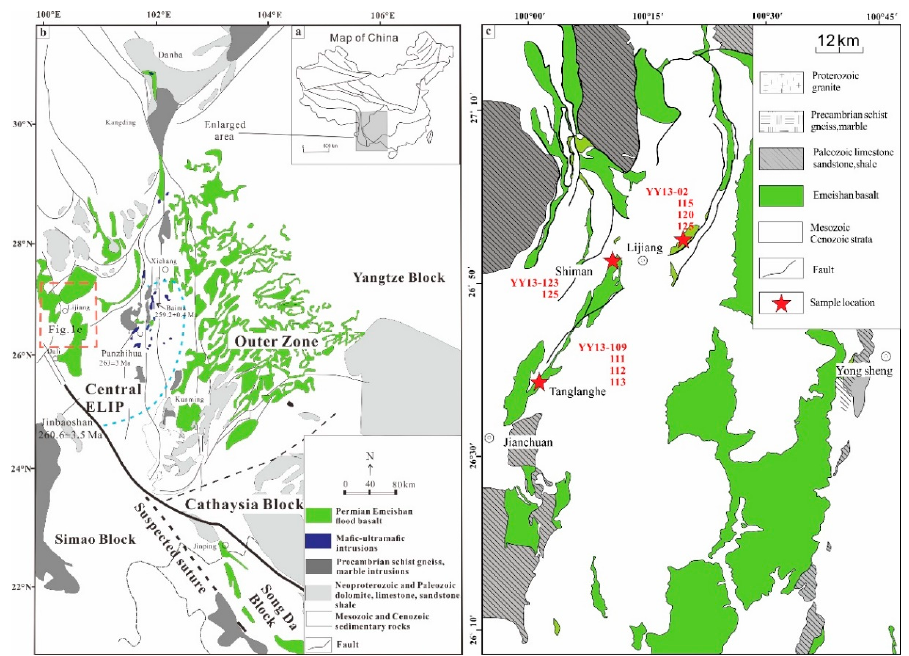
Figure 1. ( a ) Geologic map showing the simplified tectonic framework of China. ( b ) Distribution of the late-Permian Emeishan flood basalts and coeval mafic intrusions, modified after Yu et al. (2017) [6]. ( c ) Sample locations in this study.